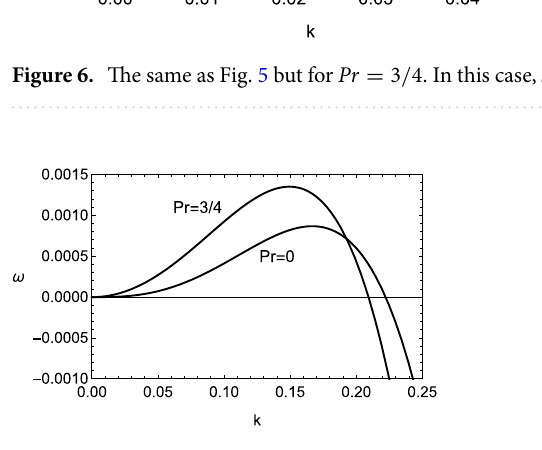
Figure 7. Growth rate ω v.s. wavenumber k for two values of Prandtl number Pr 0.1 and le 4.5 ) q le 1 ( = = = −